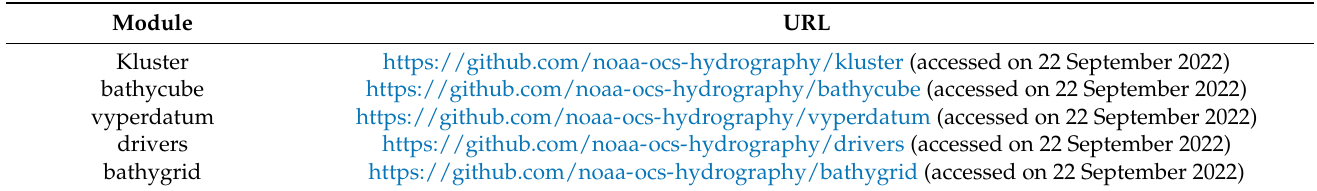
Table 1. Kluster and submodule